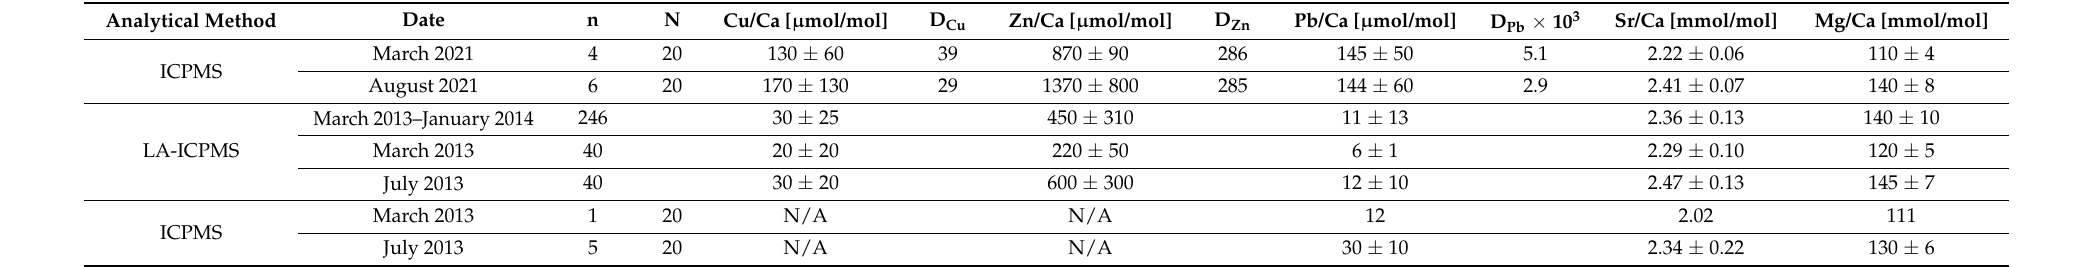
Table 1. Metal/Ca (average ± 1 SD) and partition coefficients for Lachlanella sp. Each reported value represents the average of replicate analyses (n), where each replicate analysis represents the combined composition of N specimens. Replicates for LA-ICPMS represent the sum of single-chamber measurements of all specimens. The partition coefficients (D metal ) between metal/Ca calcite and metal/Ca SW for each metal were calculated based on the average seawater values (n = 2) reported here for the study site.